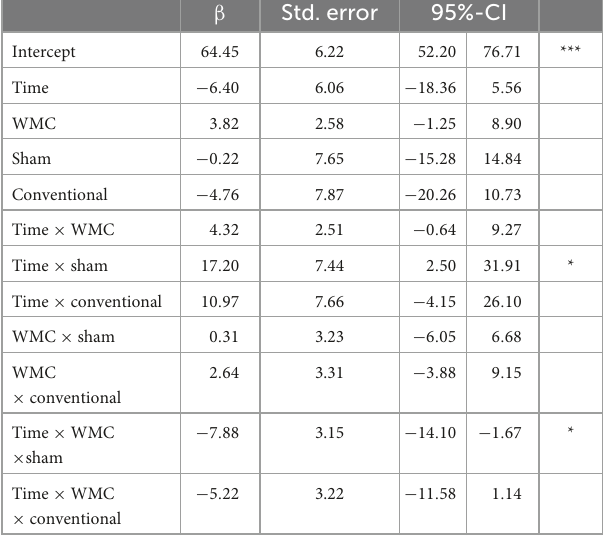
TABLE 3 Full linear mixed model for the distractor condition